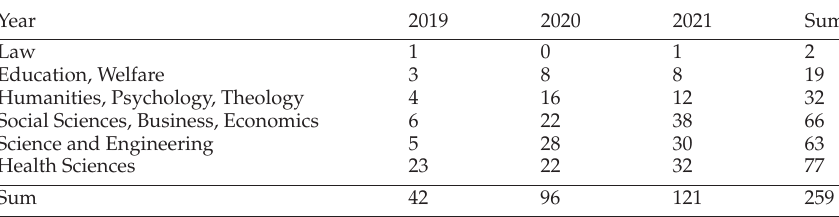
Table 2: Participants by their disciplines 2019–2021.